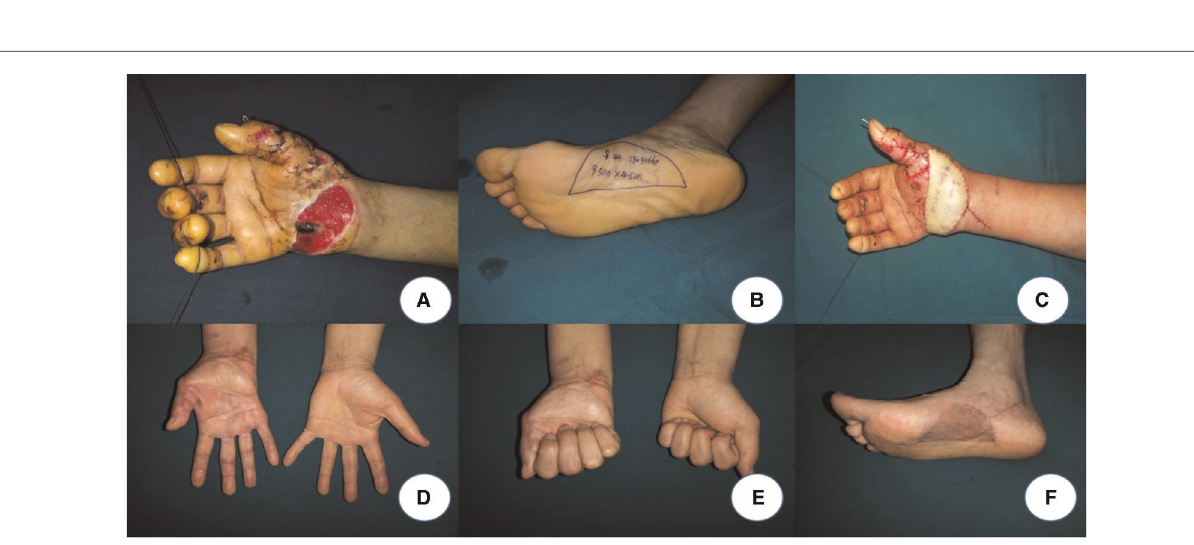
FIGURE 1 | A : Palmar soft-tissue defect on the left hand. B – D : Design of the fl aps. E , F : The defect of palm was repaired by medial plantar artery fl ap, and a SCIP was used to cover the donor site. G – I : A 24-month follow-up after the operation.